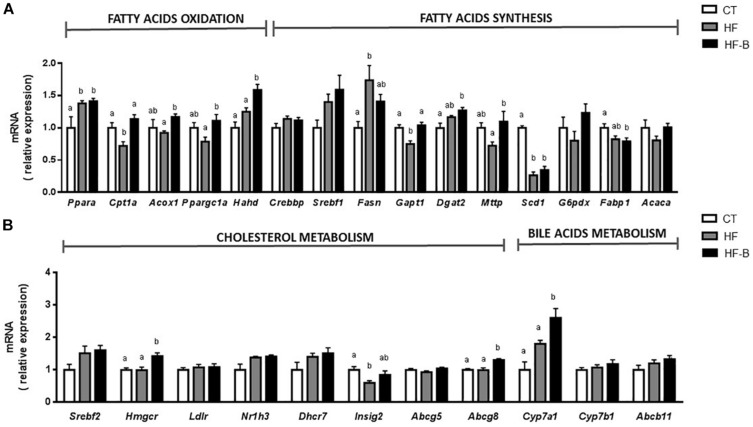
Liver gene expression of fatty acids metabolism (A) and gene expression of cholesterol and bile acid metabolism (B) after a short-term high fat diet (HFD). Mice fed a control diet and delivery vehicle-skimmed milk in drinking water (CT), mice fed a HFD and skimmed milk in drinking water (HF), and mice fed a HFD and supplemented with a suspension of 5 × 108 cfu/mouse/day of B. animalis IPLA R1 strain in skimmed milk (HF-B) added to the drinking water. Each gene codes for the same name of the corresponding enzyme except Acaca that codes for ACC (Acetyl-CoA carboxylase) and Nr1h3 that codes for LXR (liver X receptor). Data are expressed as the mean ± SEM. Values are expressed as relative units with the mean of CT mice values set at 1. Data with different superscript letters are significantly different at p < 0.05 according to One-way analysis of variance statistical analysis followed by Tukey post hoc.